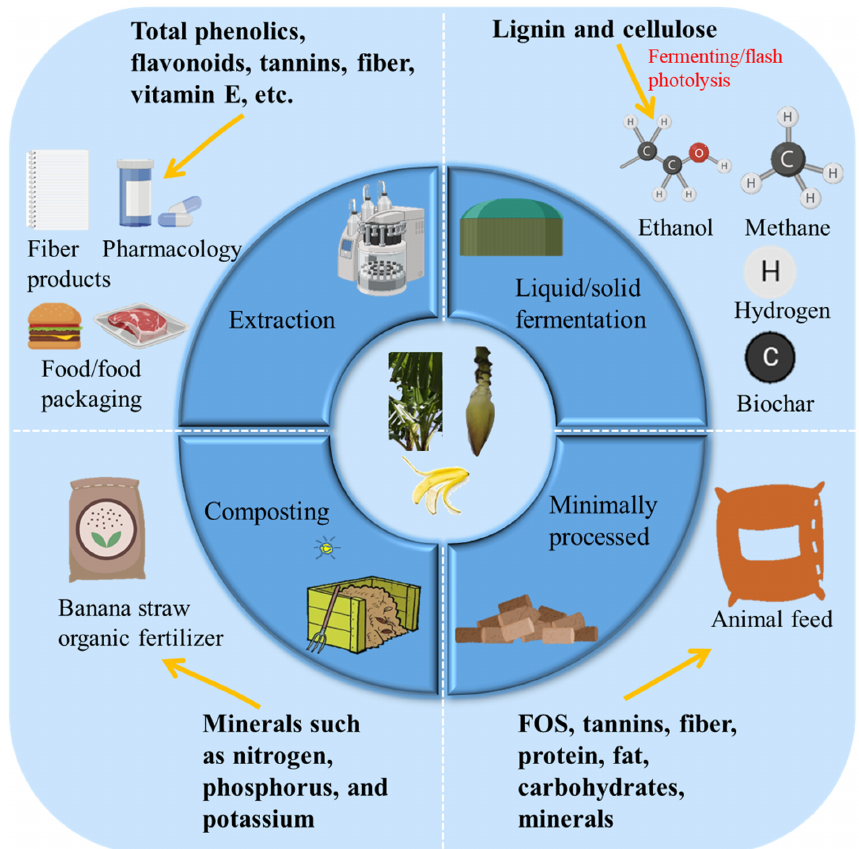
Figure 3. Integrated use of banana